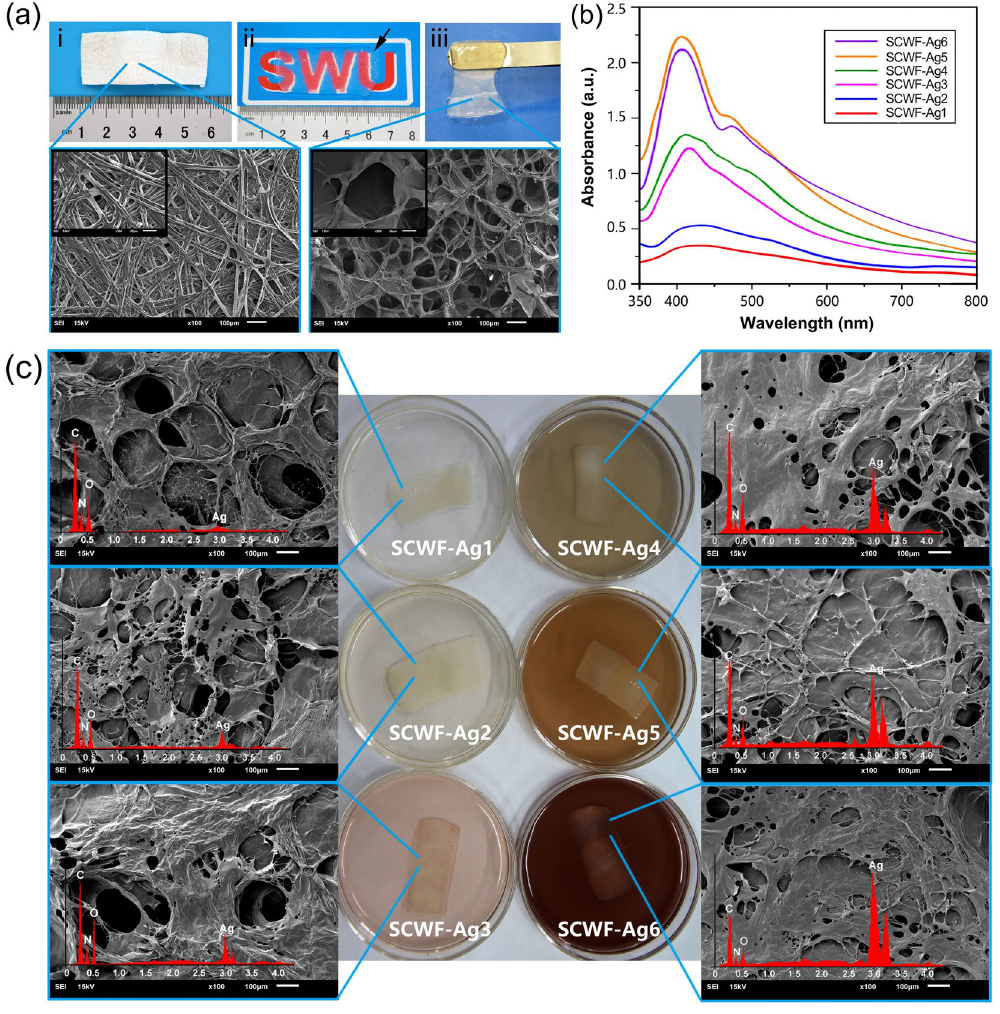
Figure 2. ( a ) Natural Bombyx mori cocoons (i); SCWF optical clarity and size (ii), wherein SCWF (black arrow) was placed on a piece of paper with one “SWU” symbol underneath. The gel (balanced on a metal spatula) was sufficiently elastic and flexible for easy handling (iii). The fibroin and sericin further dissolved to form a network that readily aggregated into transparent films, as shown in the scanning electron micrograph of lyophilized SCWF. ( b ) UV-vis absorption spectra of leaching aqueous dispersions of SCWF-Ag1–6 in deionized water. ( c ) Scanning electron micrographs of lyophilized SCWF-Ag1–6 with red curves of EDX and photographs of the respective SCWFs immersed in different concentration of AgNO 3 aqueous solution after 4 h.